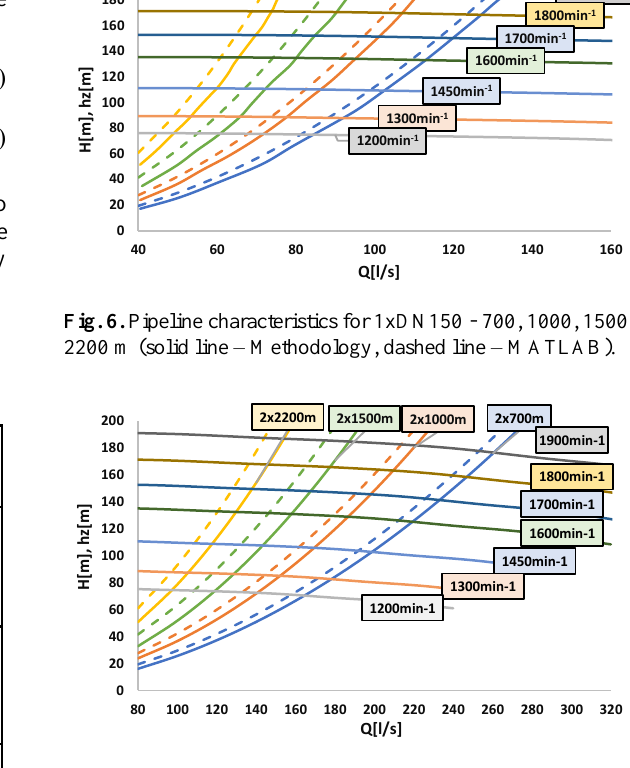
Fig. Pipeline characteristics for 2xDN150 - 700, 1000, 1500, 7. 2200 m (solid line – Methodology, dashed line – MATLAB) .